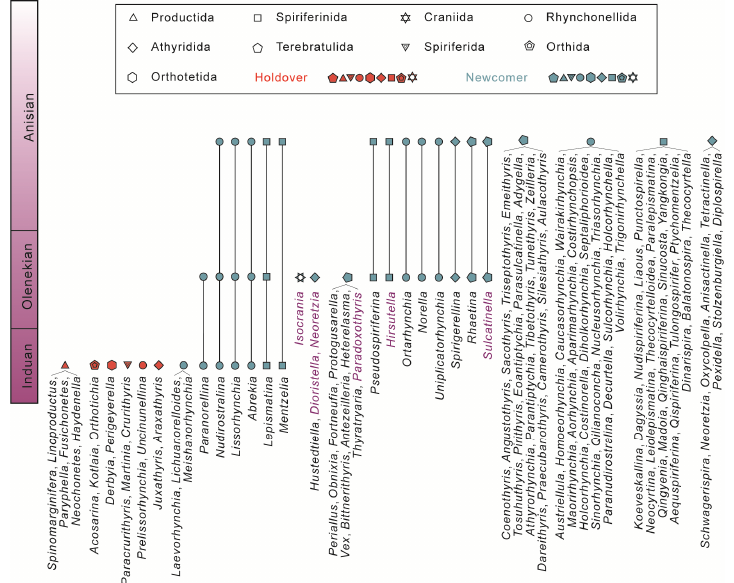
Figure 3. Occurrences of brachiopod genera (Lingulida excluded) worldwide during the Early and Middle Triassic based on data from the Datuguan section and PBDB. Genera shown in purple are described from the Olenekian for the first time in this paper.